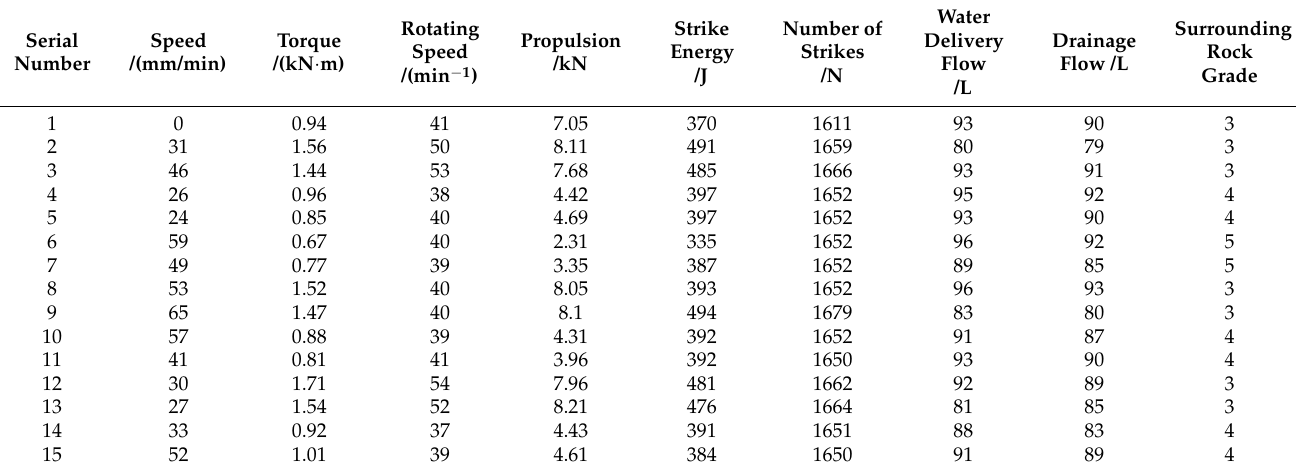
Table 2. Samples of drilling parameters in the Qingdao Jiao Zhou Bay Subsea Tunnel.